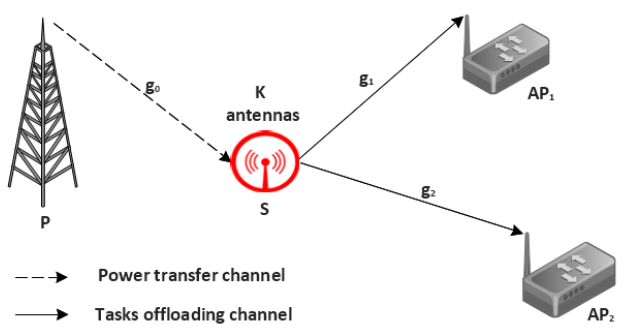
Figure 1. System Model for RF Energy Harvesting NOMA MEC Network